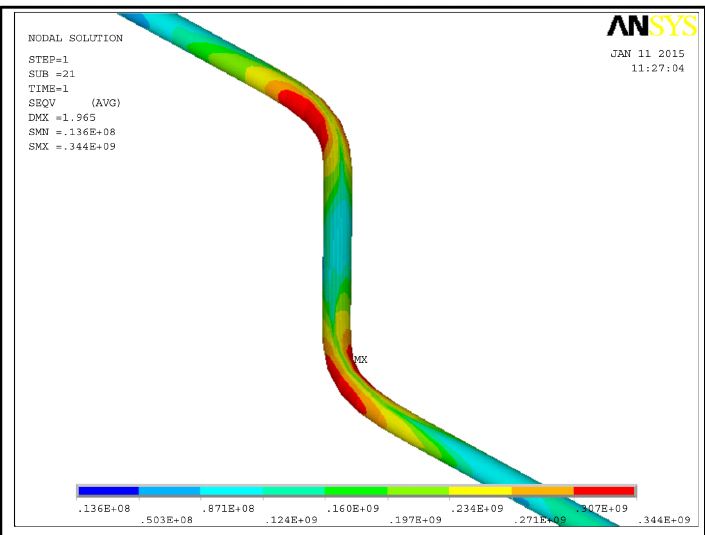
Figure 10. Pipeline stress cloud diagram.